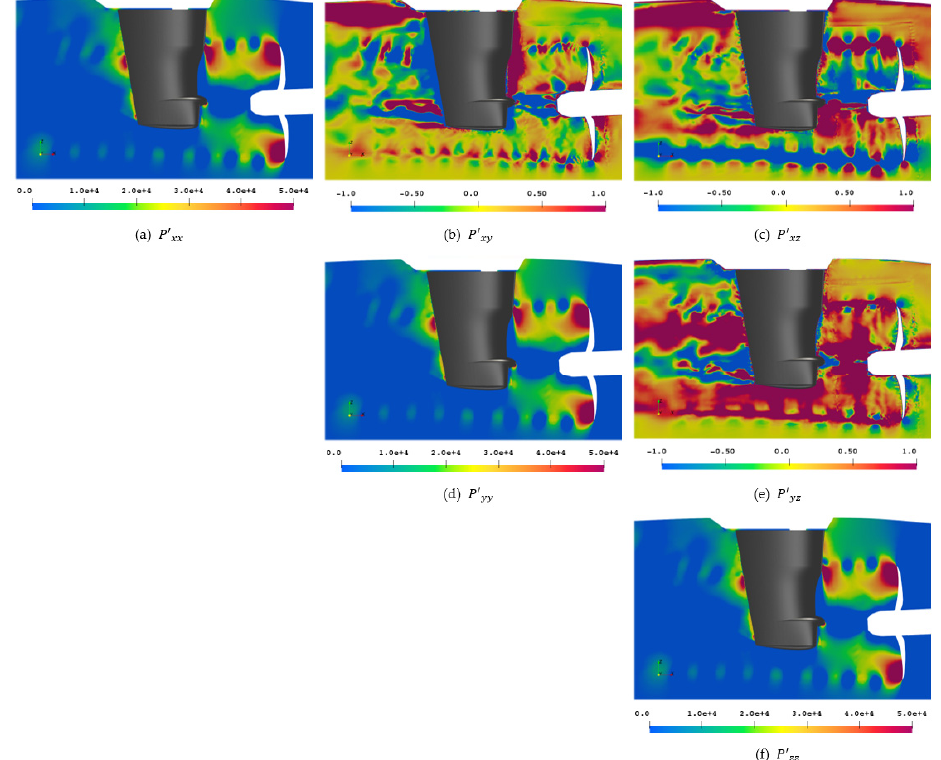
Figure 21. Perturbation stress tensor 𝑃′ (cid:3036)(cid:3037) in [Kg/ms (cid:2870) ].